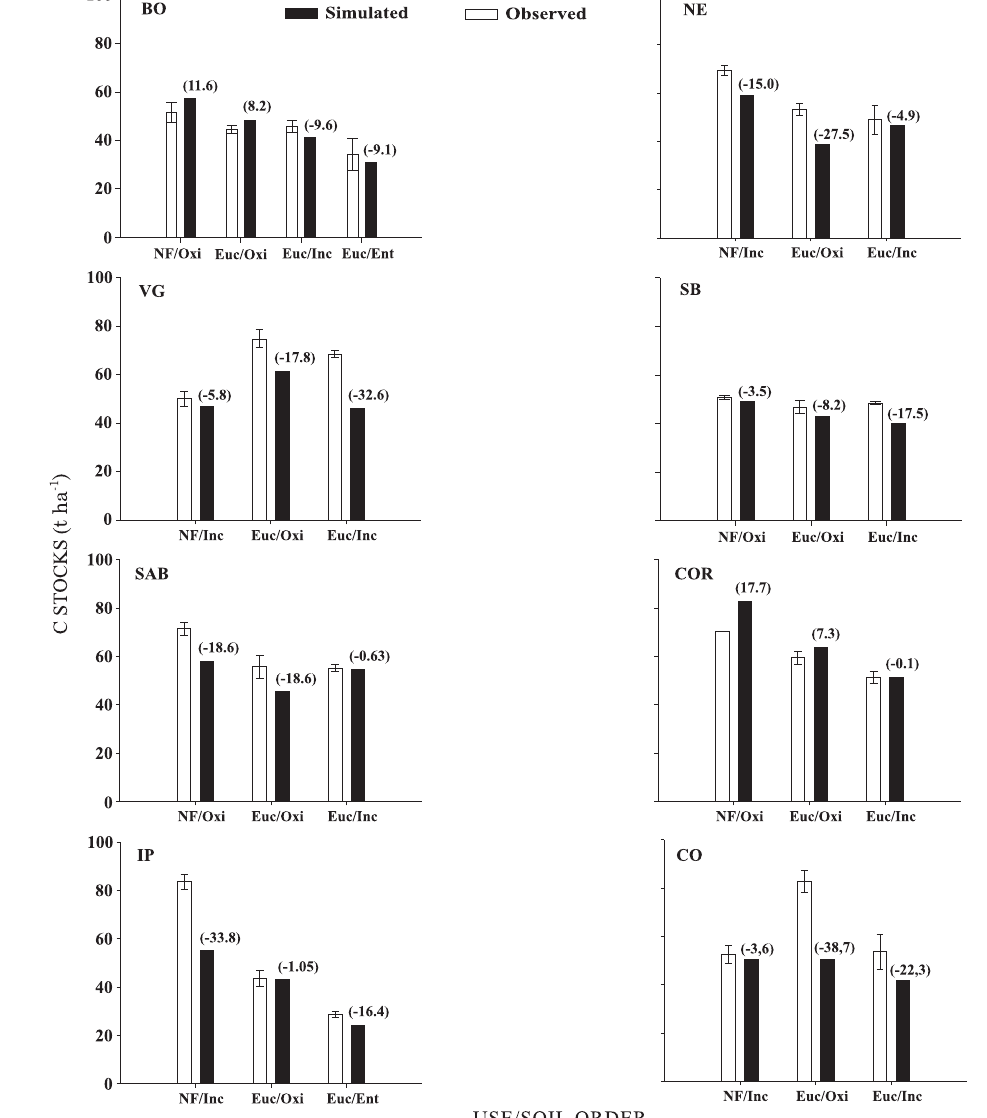
Figure 3. Observed and simulated SOC stocks of the 0–20 cm layer of soils of the regions of Belo Oriente (BO), Nova Era (NE), Santa Bárbara (SB), Virginópolis (VG), Sabinópolis (SAB), Correntinho (COR), Ipaba (IP) and Cocais (CO). The values in brackets refer to the difference (%) between simulated and observed values. NF – Native forest, Euc – Eucalyptus, Oxi – Oxisol, Inc – Inceptisol, Ent –